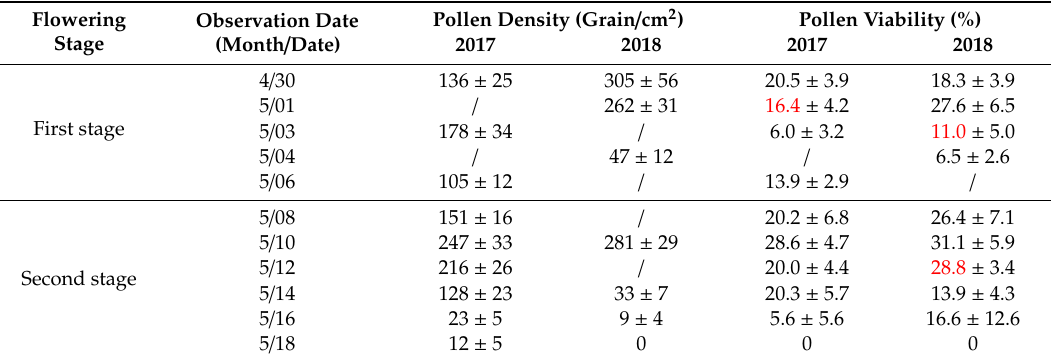
Table 3. Pollen density and viability during the flowering period in 2017 and